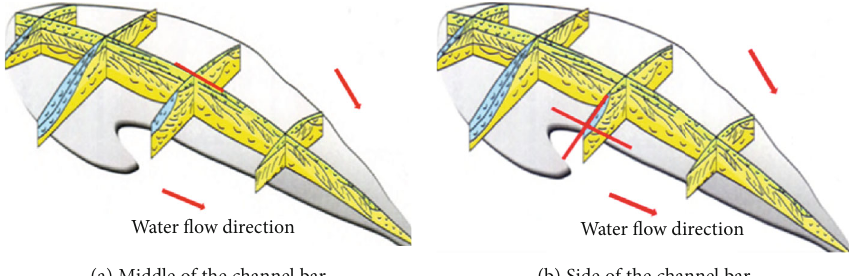
Figure 14: Channel bar sedimentary structure.